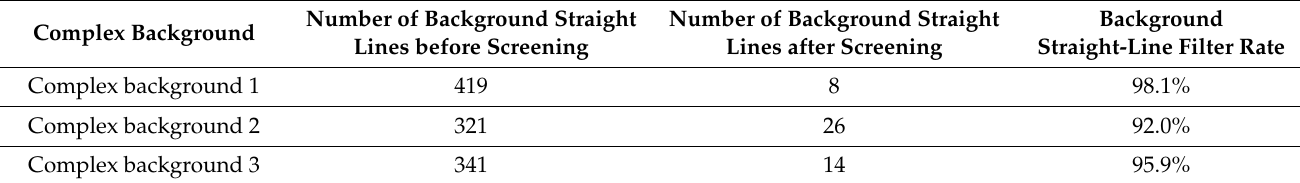
Table 2. Background straight-line filter rate.